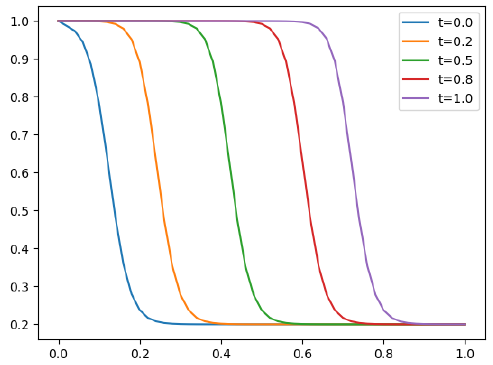
Figure 3. Final profiles at different times when N = NT = 50.